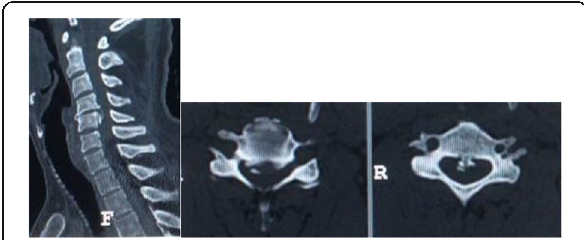
Fig. 3 CT of cervical spine showing focal stenosis due to C5